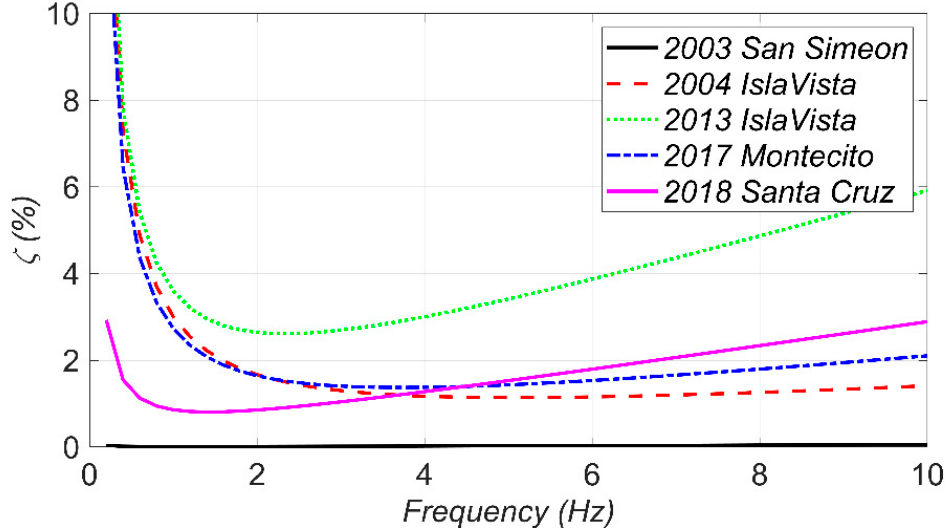
Figure 14. The final estimates of the Rayleigh damping ratio as a function of freqeuncy for different